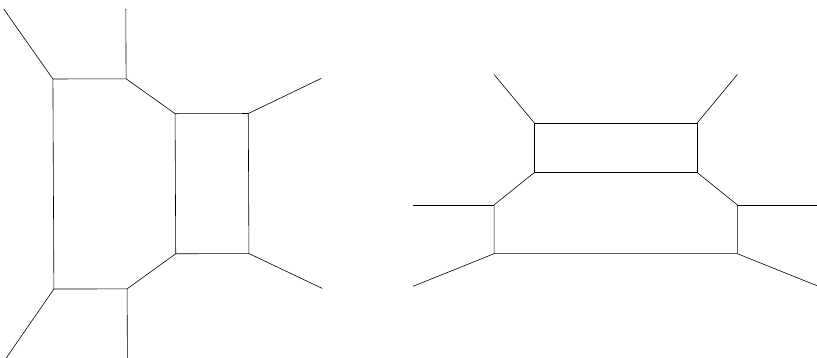
Figure 4 . Example of a 5d quiver CFT and its S-dual. In the left figure horizontal lines are associated to D5-branes and vertical lines to NS5-branes. It describes a 5d gauge theory with gauge group SU(2) × SU(2) . In the right figure D5 and NS5 branes are exchanged, such that it